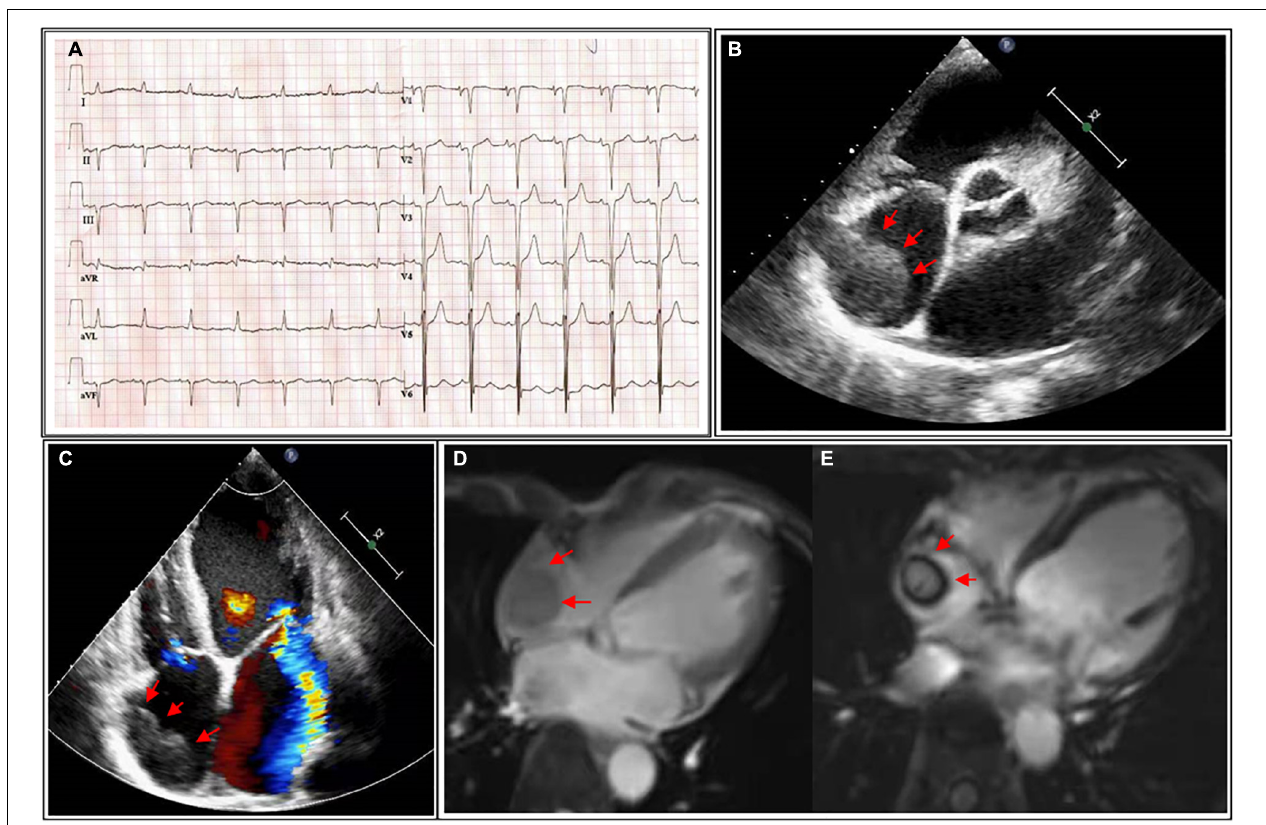
FIGURE 1 | (A) Electrocardiogram showing poor R waves in V5 and V6, as well as QS waves in the precordial and inferior leads. (B) Parasternal short-axis view of transthoracic echocardiography (TTE) detecting an isolated giant mass (26 × 30 mm) in the right atrium (red arrow). (C) Four-chamber view with color-Doppler of TTE showing a giant mass in the right atrium (red arrow) and severe mitral regurgitation. (D) T1-weighted imaging of cardiac magnetic resonance imaging (CMR) indicating the mass in the right atrium (red arrow) with medium-to-high signal intensity. (E) Delayed enhancement imaging of CMR identifying a thrombotic nature mass (red arrow). TTE, transthoracic echocardiography; CMR, cardiac magnetic resonance